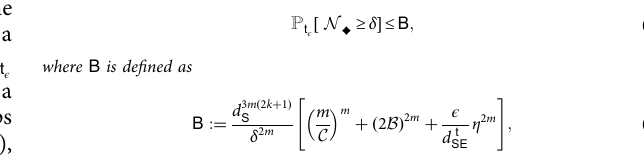
Fig. 2: as individual random two-body interactions of each kind accumulate, what we expect is for the dynamics to start scrambling their information across the whole gas in the box, progressively becoming more complex and uniformly random 55 . Unitary designs give us this fi nite quanti fi cation of the approximation to uniform Haar randomness and, in this case, it can give us a precise way to account for the progressive emergence of complexity from seemingly simple individual two- body interactions.